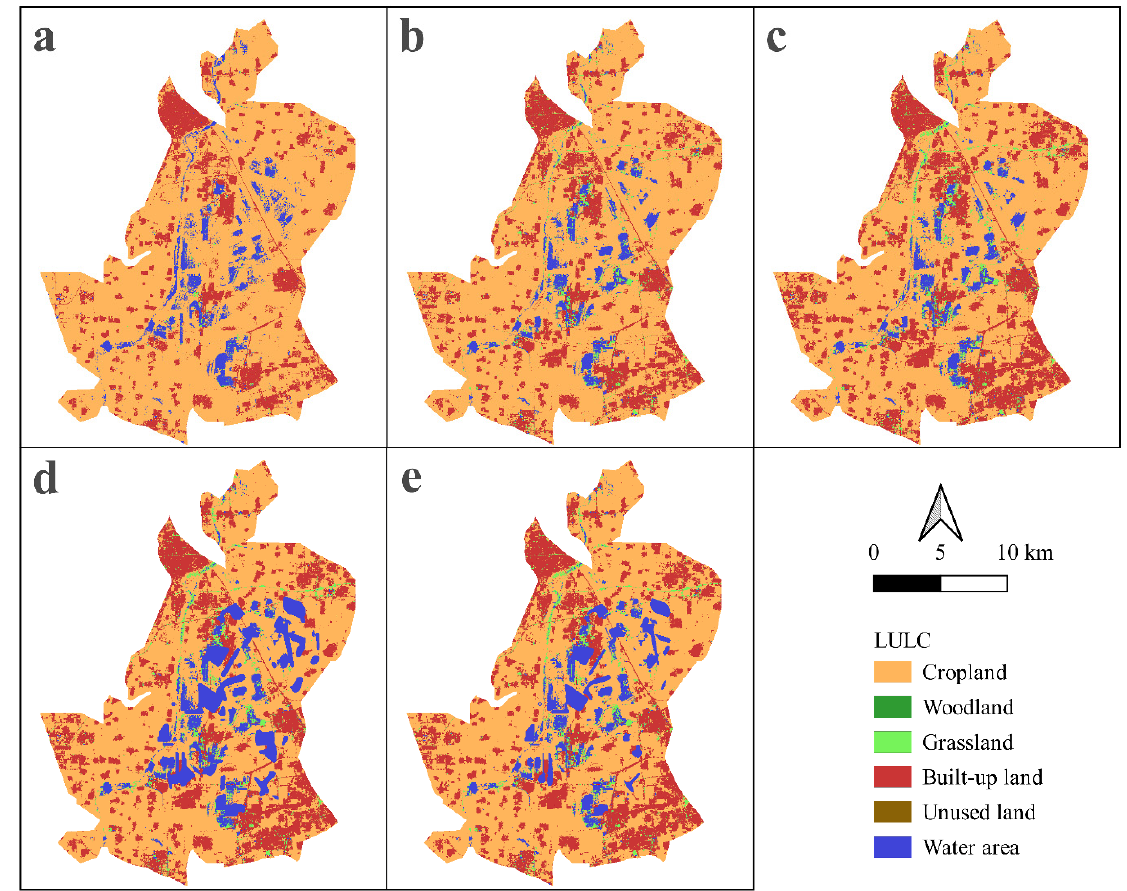
From the spatial distribution of different LULC, the new built-up land in 2030 would be distributed around the original built-up land. The newly added water bodies in NRM and MR scenarios would basically be within the mining subsidence range and would mainly be areas that were originally cropland. It can be seen that mining severely impacts YZC’s food security. Figure 6. Spatial distribution of LULC: ( a ) 2010; ( b ) 2020; ( c ) NMA; ( d ) NRM; ( e ) MR.